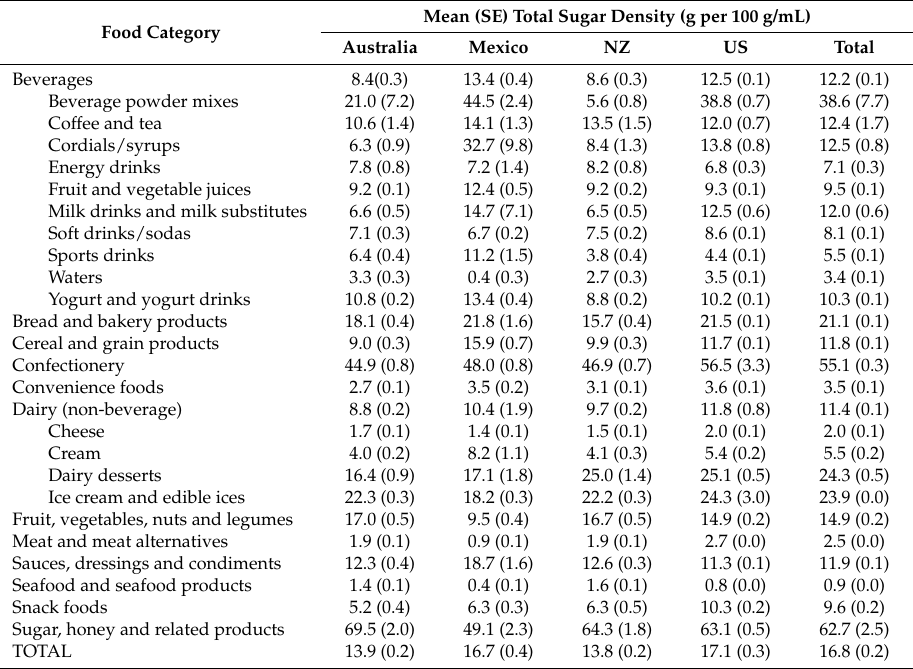
Table 2. Mean (SE) total sugar density (g per 100 g or 100 mL) by food category and country.